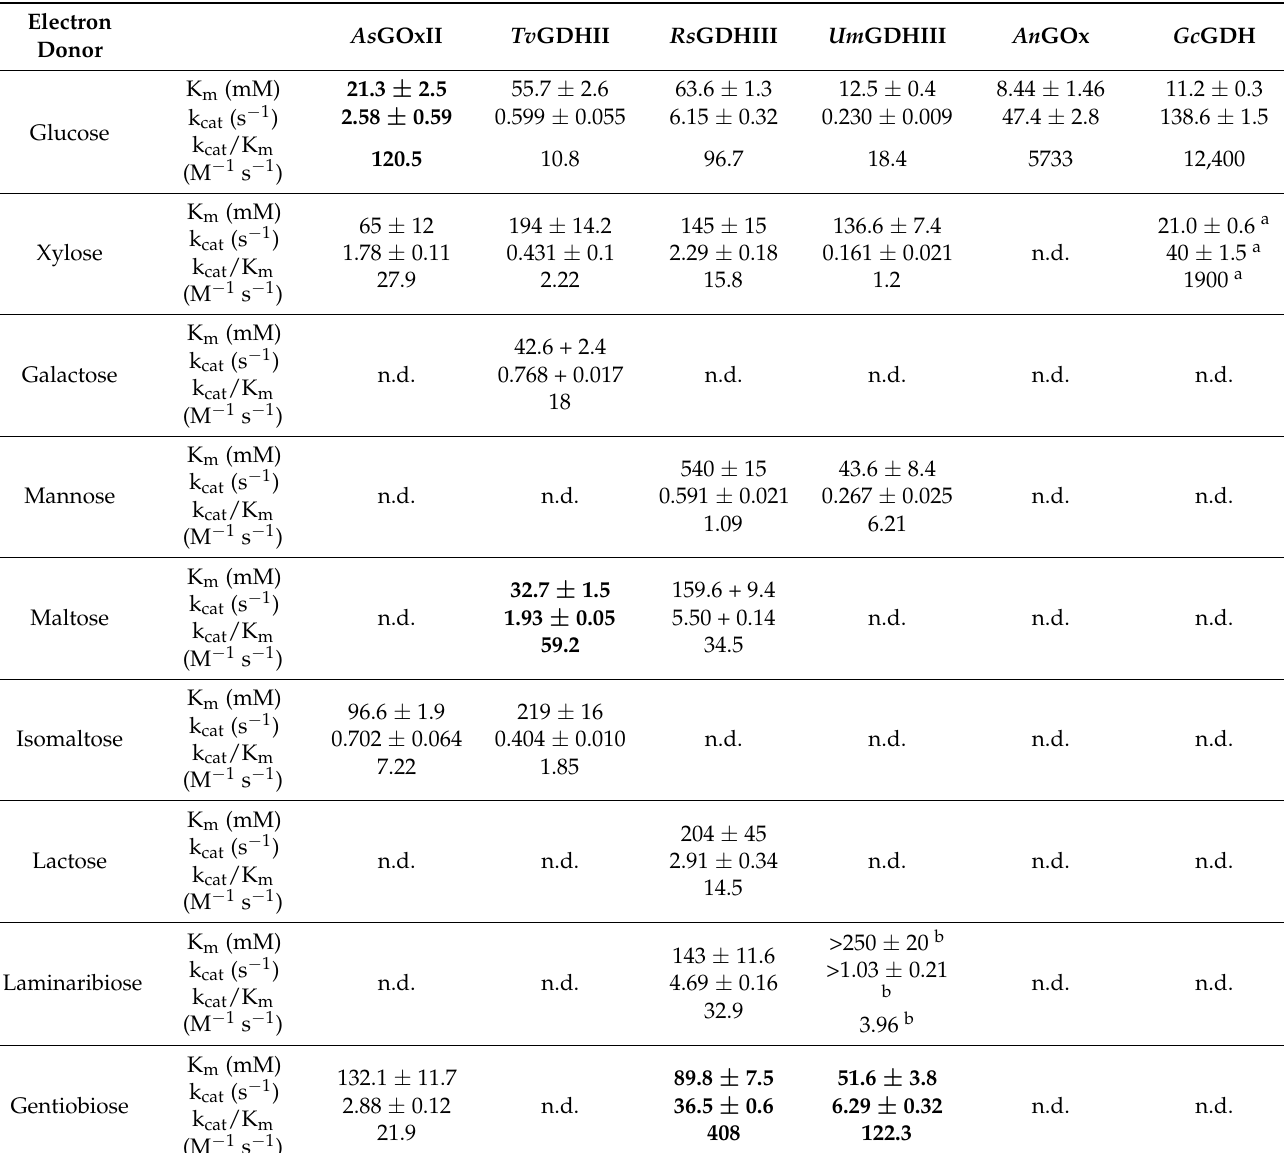
Table 3. Apparent steady-state kinetic constants of various AA3_2 glucose oxidoreductases. The concentration of the sugars was varied w ile using 1,4-benzoquinone as electron acceptor at a fixed concentration of 0.5 mM. Measurements were performed at pH 6.5 and 30 ◦ C. Highest catalytic efficiencies are shown in